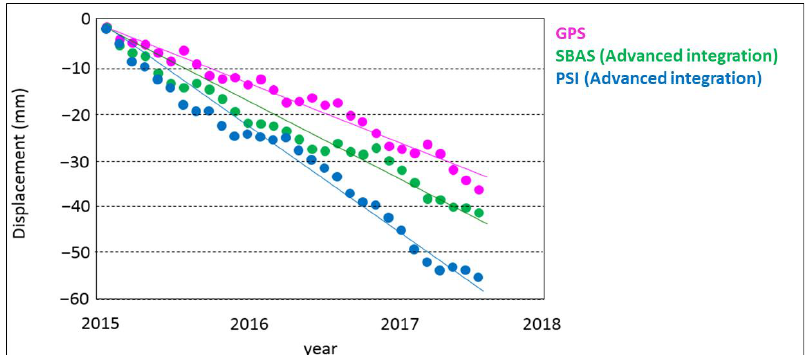
Figure 9. Comparison of the time series trend of the GNSS station with the time series of the PSI and SBAS techniques.